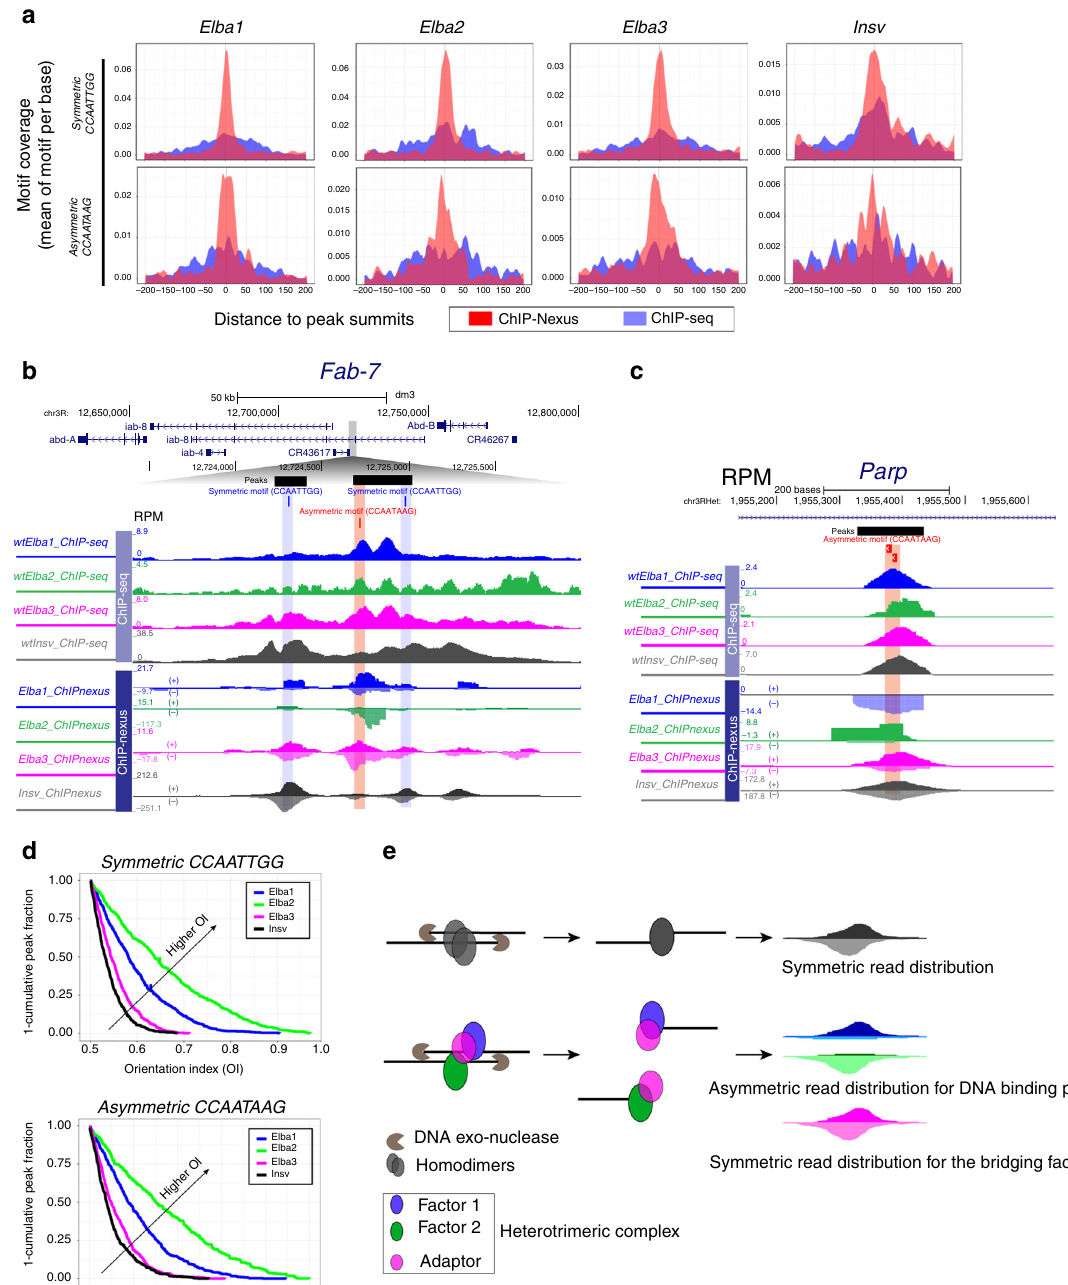
Fig. 3 ChIP-nexus distinguishes homodimer from heterotrimeric binding. a Comparison of ChIP-seq and ChIP-nexus, showing centered motif distribution around the peak summits. The motif occurrence centered at the peak summits ( x -axis) is plotted with mean motif coverage in “ Motif Per Base ” on the y - axis. b ChIP-seq and ChIP-nexus tracks of the Fab-7 region show broader ChIP-seq peaks while sharp ChIP-nexus peaks. Note: ChIP-nexus also shows asymmetric read distribution of Elba1 and Elba2 and symmetric distribution of Elba3 and Insv. Elba1 and Elba2 respectively prefer the “ + ” and the “ − ” strand of the CCAATAAG motif. c Another exemplary locus, Parp , exhibits a similar bias of strand asymmetry. d The orientation indexes (OIs), ranging from 0.5 – 1, were calculated for the top 500 ChIP-nexus peaks containing the symmetric or asymmetric motifs (see the Methods section). Elba1 and Elba2 display a higher OI tendency than Elba3 and Insv, suggesting asymmetric binding. e Illustration of how ChIP-nexus can capture symmetric versus asymmetric binding patterns by homodimers versus a heterotrimeric